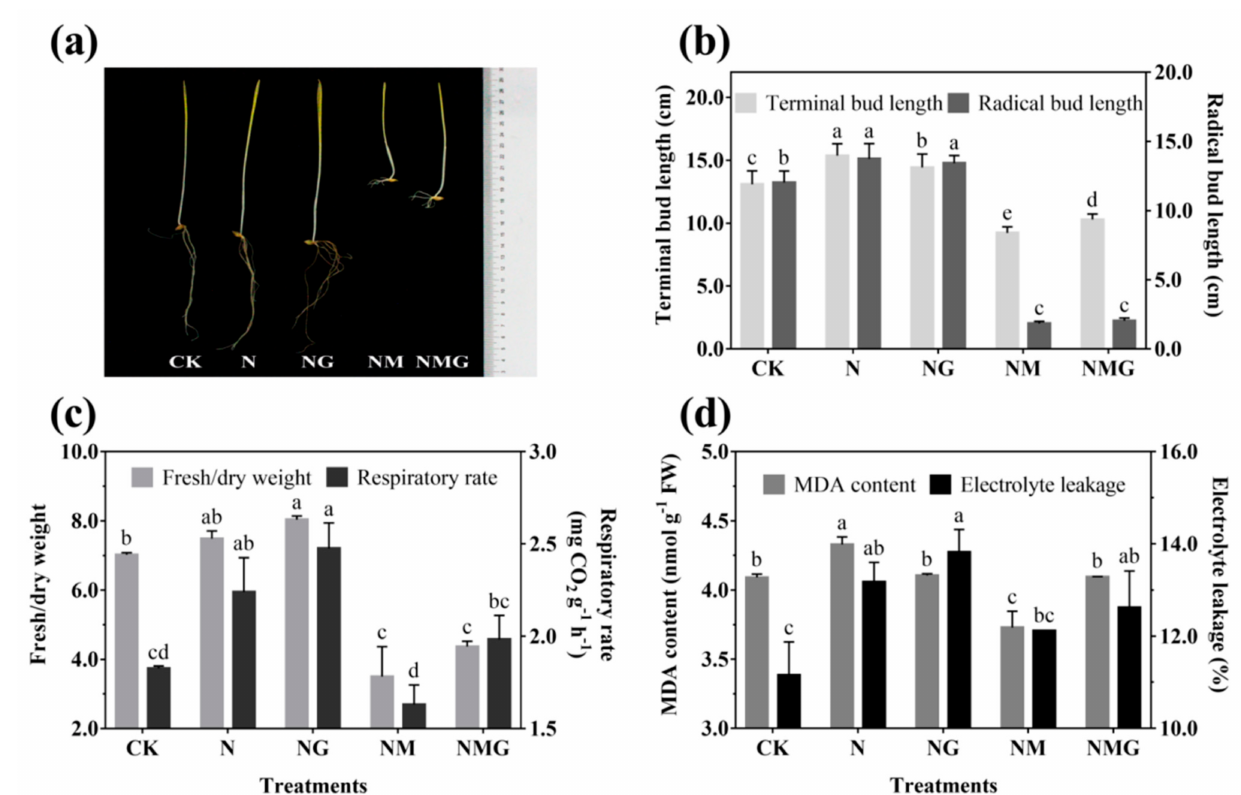
Figure 2. The effect of GABA on the growing status ( a ), terminal/radical bud length ( b ), ratio of fresh to dry weight and respiratory rate ( c ), and MDA content and electrolyte leakage ( d ) of 6-day-old barley seedlings under 20 mmol L − 1 NaCl. The lower case letters for each index indicate significant differences at p < 0.05 among different treatments. One-way ANOVA was used for data analysis. The data were presented as mean ± SD, n ≥